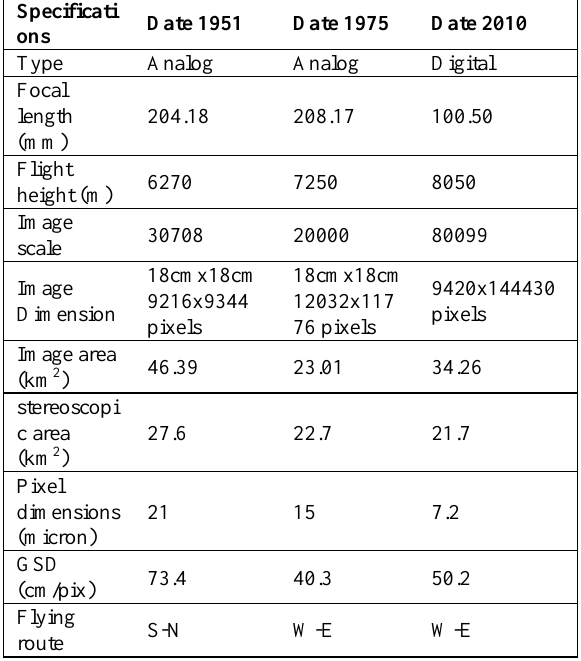
Table 1. The specifications of aerial images used in this study The date of 1951 and 2010 have two stereoscopic images, and the date of 1975 has three stereoscopic images that have 70% overlap on forward direction. The orientation parameters of these images are not known before the process.